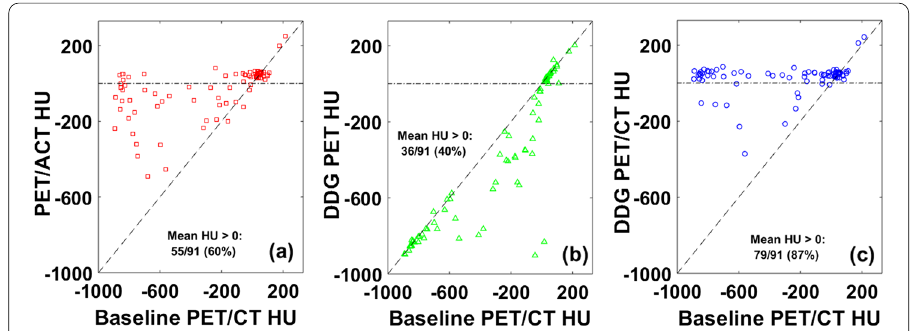
Fig. 2 Scatter plots of lesion mean HU relative to baseline PET/CT for: a PET/ACT, b DDG-PET, and c DDG-PET/CT. In each figure, the number (%) of lesions with a mean HU > 0 is included. Note that at baseline, 38/91 (42%) lesions had mean HU > 0. The dashed line in each figure is the line of equivalence, while the dash-dot line is plotted at HU =